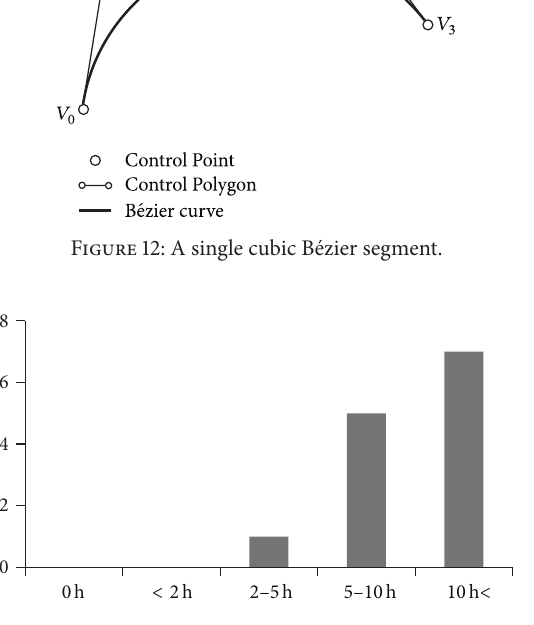
Figure 13: Experience in computers: the vertical axis indicates the number of participants.